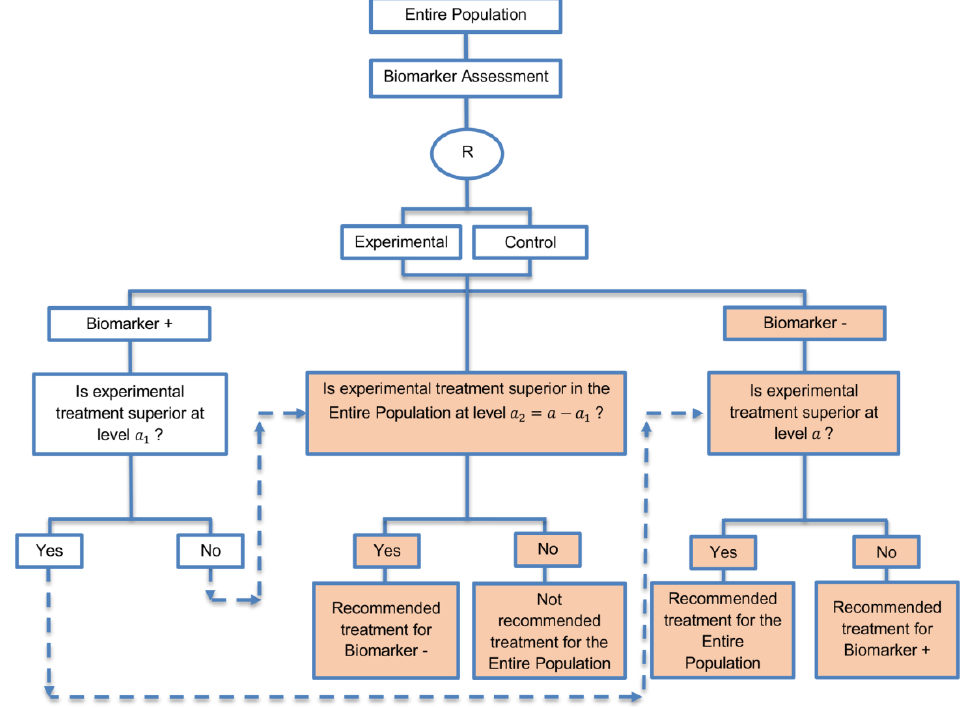
Figure 10. Marker Sequential test design (MaST). “R” refers to randomization of patients. Uncolored boxes are referred to the first stage of the trial and colored boxes are referred to the second stage of